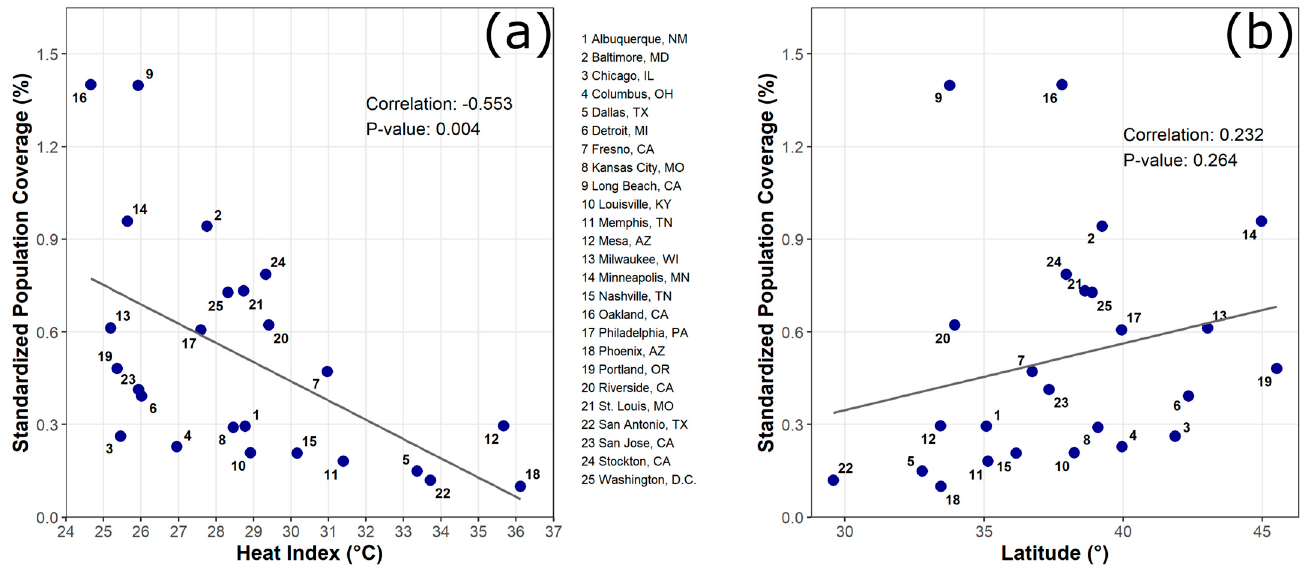
Figure 4. Associations of SPC with cities’ location characteristics. ( a ) Correlation between SPC and heat index and ( b ) correlation between SPC and latitude.